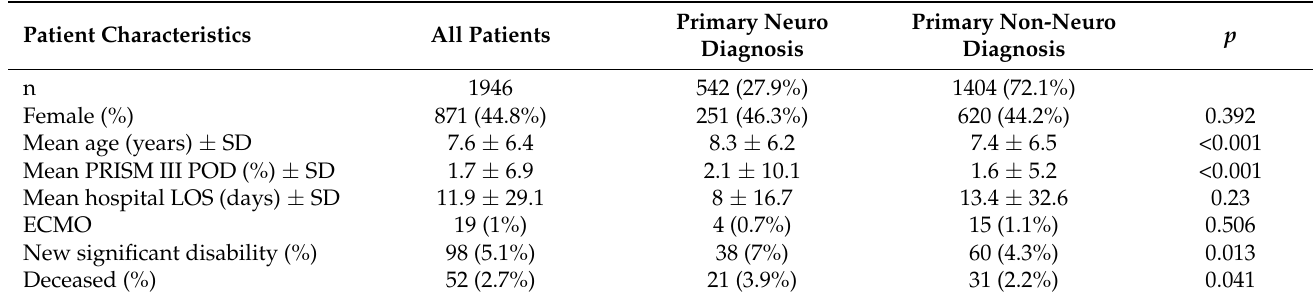
Table 1. Patient characteristics, illness severity, and